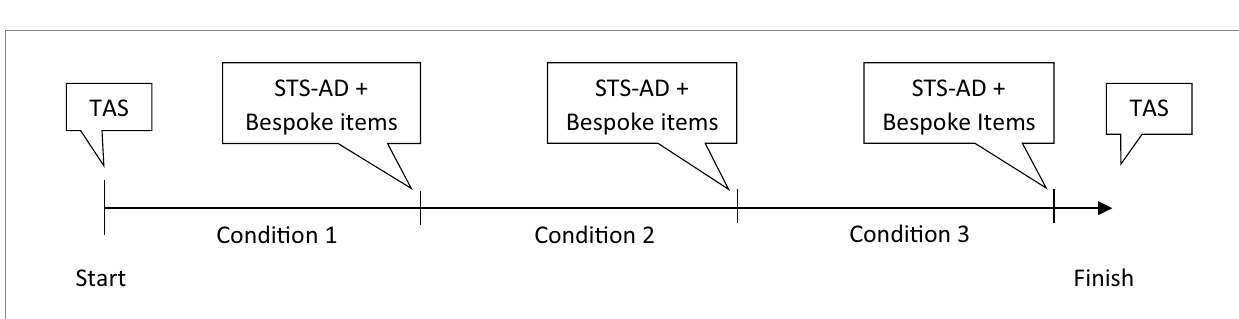
FIGURE 8 Timeline of the trust scales administration across the whole